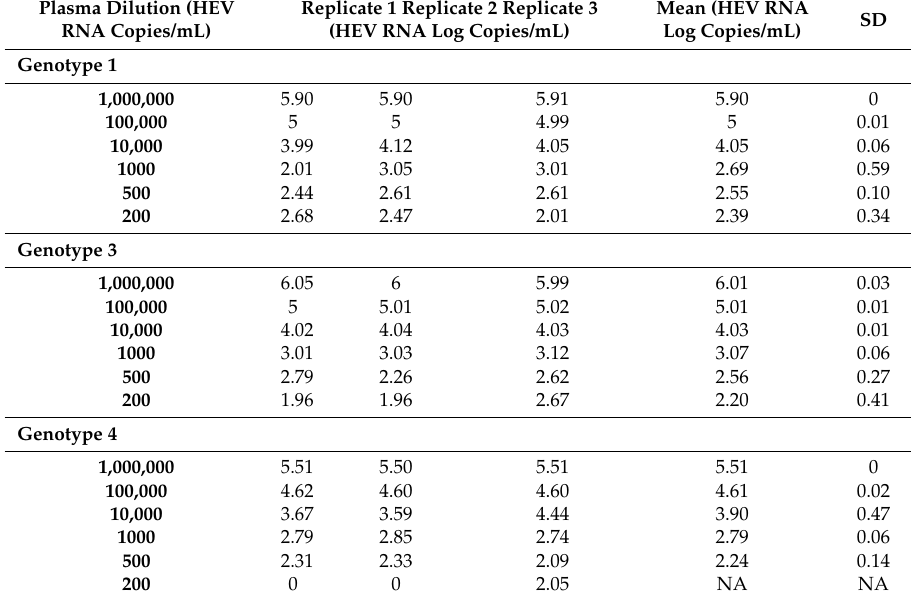
Table 1. Linearity of hepatitis E virus (HEV) RNA quantification by reverse transcriptase droplet digital PCR (RT-ddPCR). Each concentration was tested in triplicate.